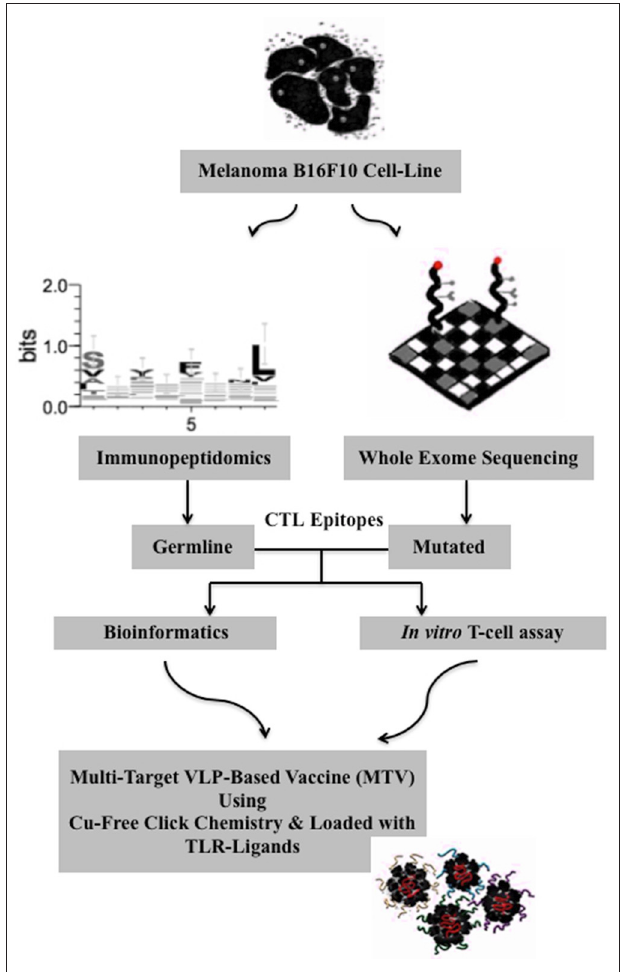
FIGURE 1 | Algorithm for the generation of a personalized melanoma vaccine platform based on VLPs. First, tumor-specific epitopes need to be identified in a systematic way. Here, immunopeptidomics approach has been used to identify potential tumor-specific germline epitopes and whole exome sequencing to predict the mutated ones. In a second step, the identified and predicted epitopes should be prioritized and this was basically achieved by bioinformatics and stimulation of tumor-infiltrating cells using in vitro T-cell assay. Next, the selected epitopes are extended to ∼ 13–14 amino acids long peptides using their flanking protein sequence for the goal of targeting CD8 + CTL. The extended peptides are then synthesized and coupled to CpG-loaded VLPs using Cu-free click chemistry. A mix-multi target VLP-based vaccine is